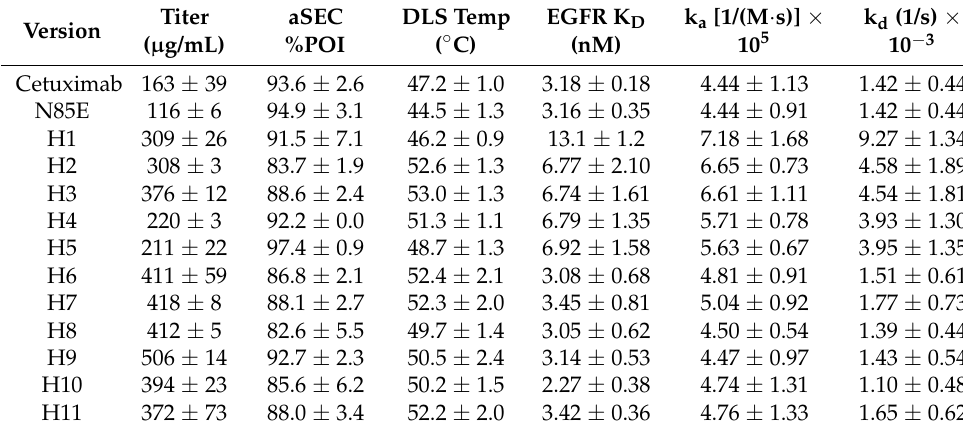
Table 2. Biophysical properties of cetuximab-derived scFv-monoFc